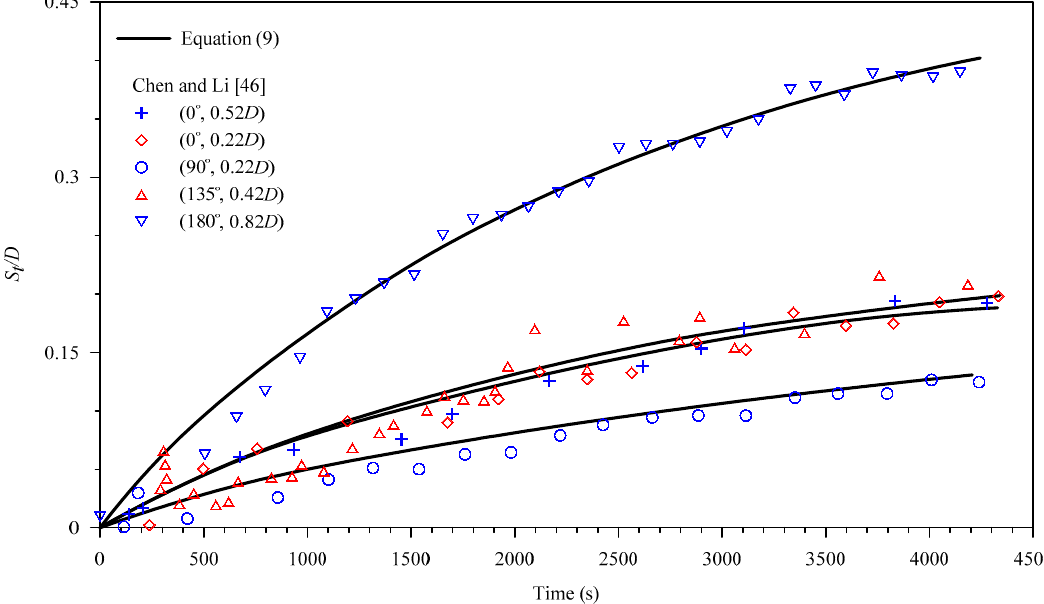
Figure 8. Temporal variation of nondimensional scour depth, S t / D , under waves at different points around a circular cylinder.